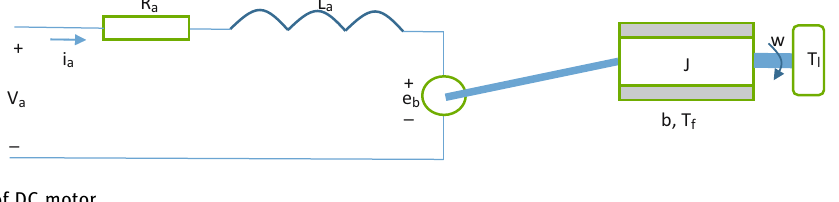
Figure 1: Schematic of DC motor.